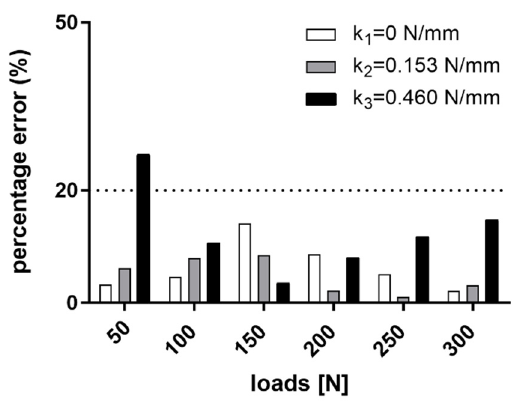
Figure 7. Percentage error between simulation and experimental results.